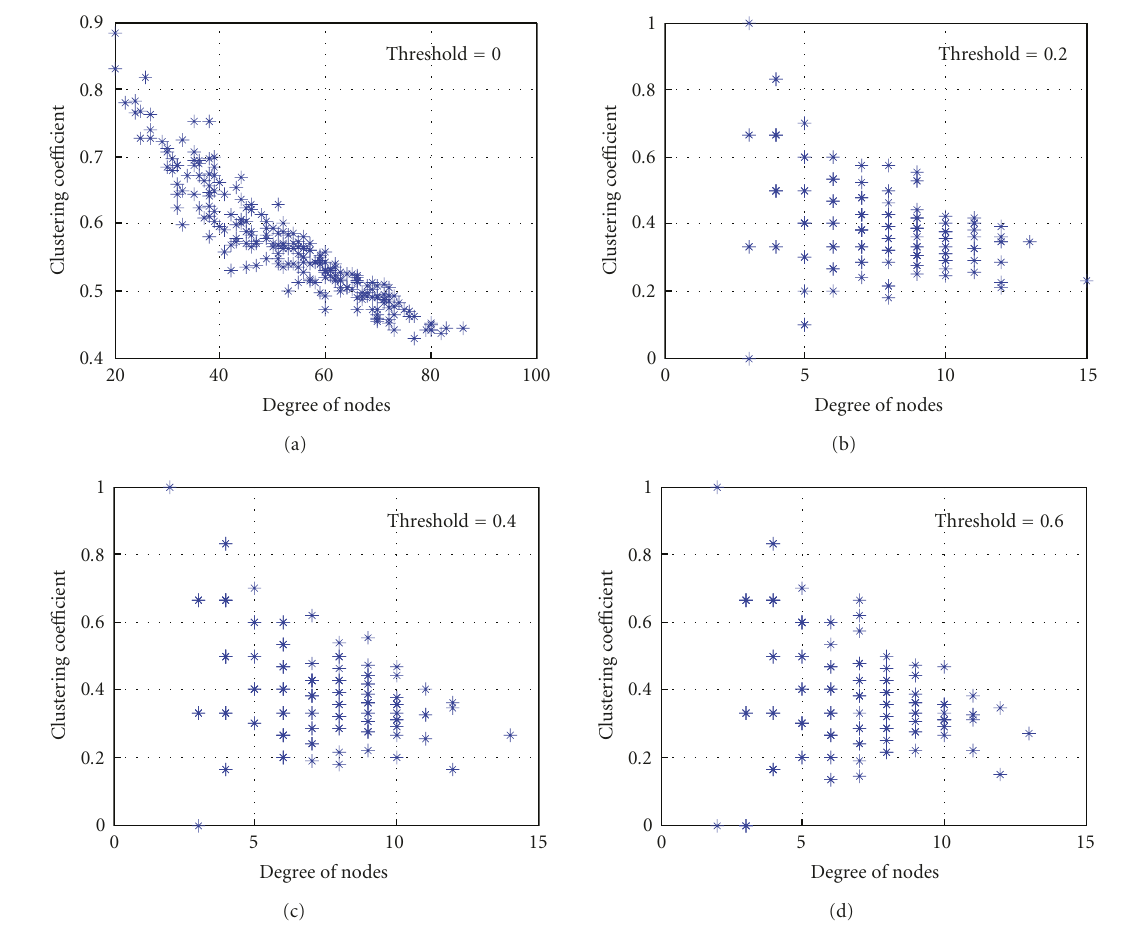
Figure 12: Variation of clustering coe ffi cient with degree of nodes: simulation